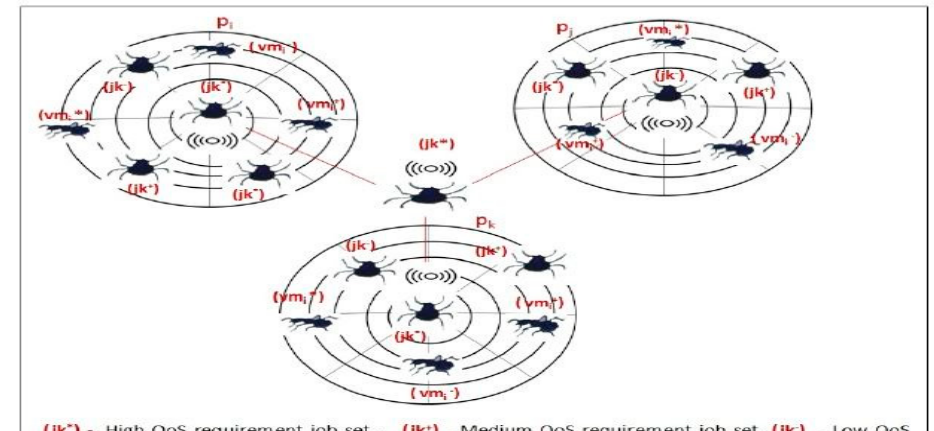
Figure 12. Behavior of social spider technique